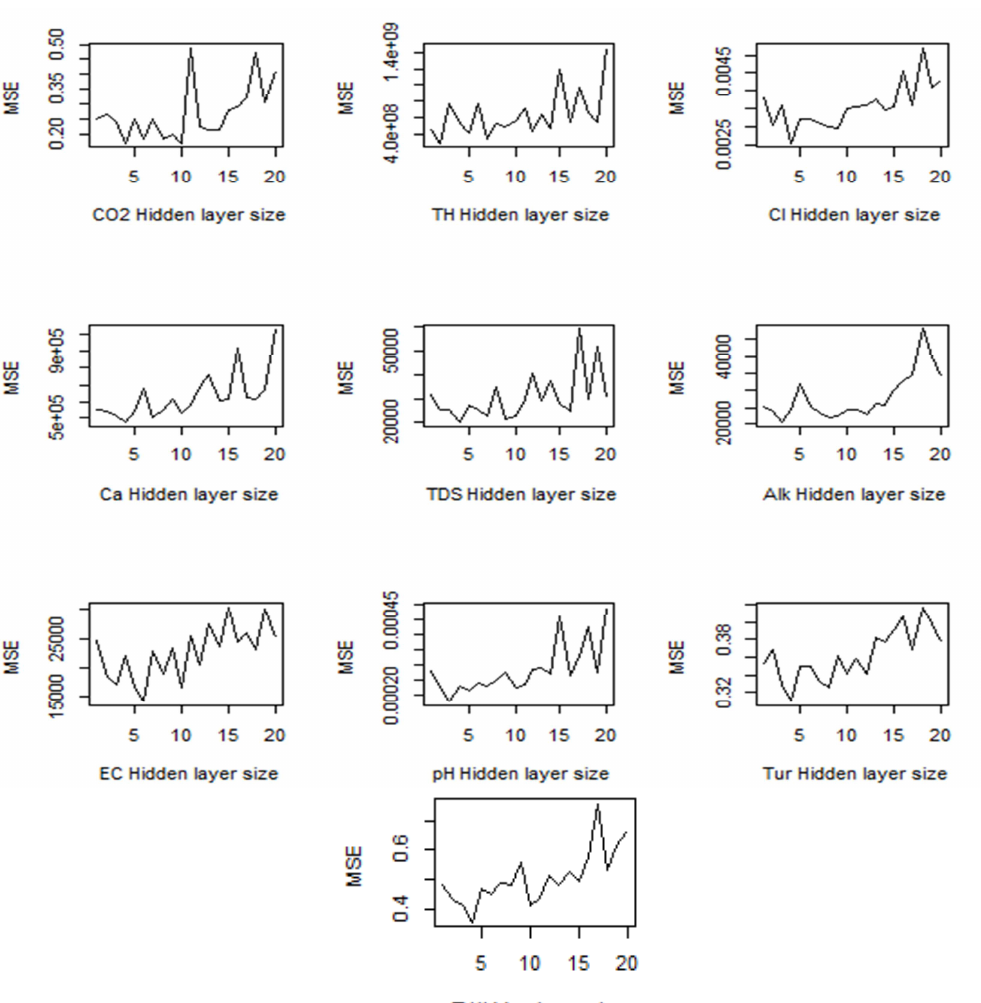
Figure 4. Hidden layer size versus network